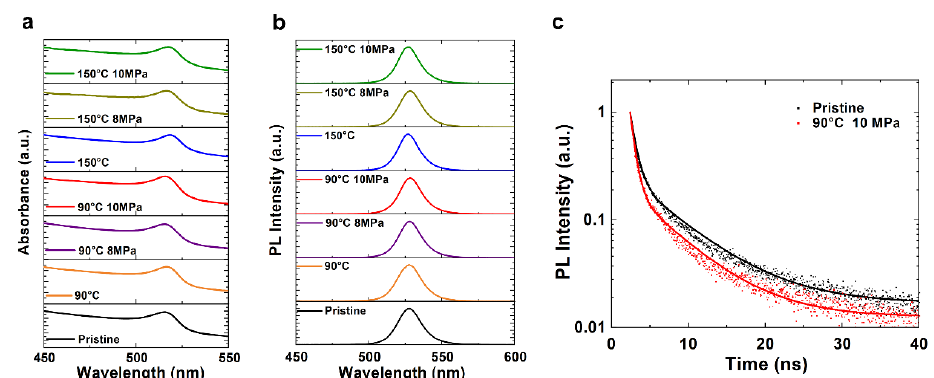
Figure 2. ( a ) XRD patterns of the pristine CsPbBr 3 film and the separated laminates prepared under different conditions, and the corresponding histograms of XRD ( b ) FWHMs and ( c ) relative peak intensities of the (100), (110), and (200)